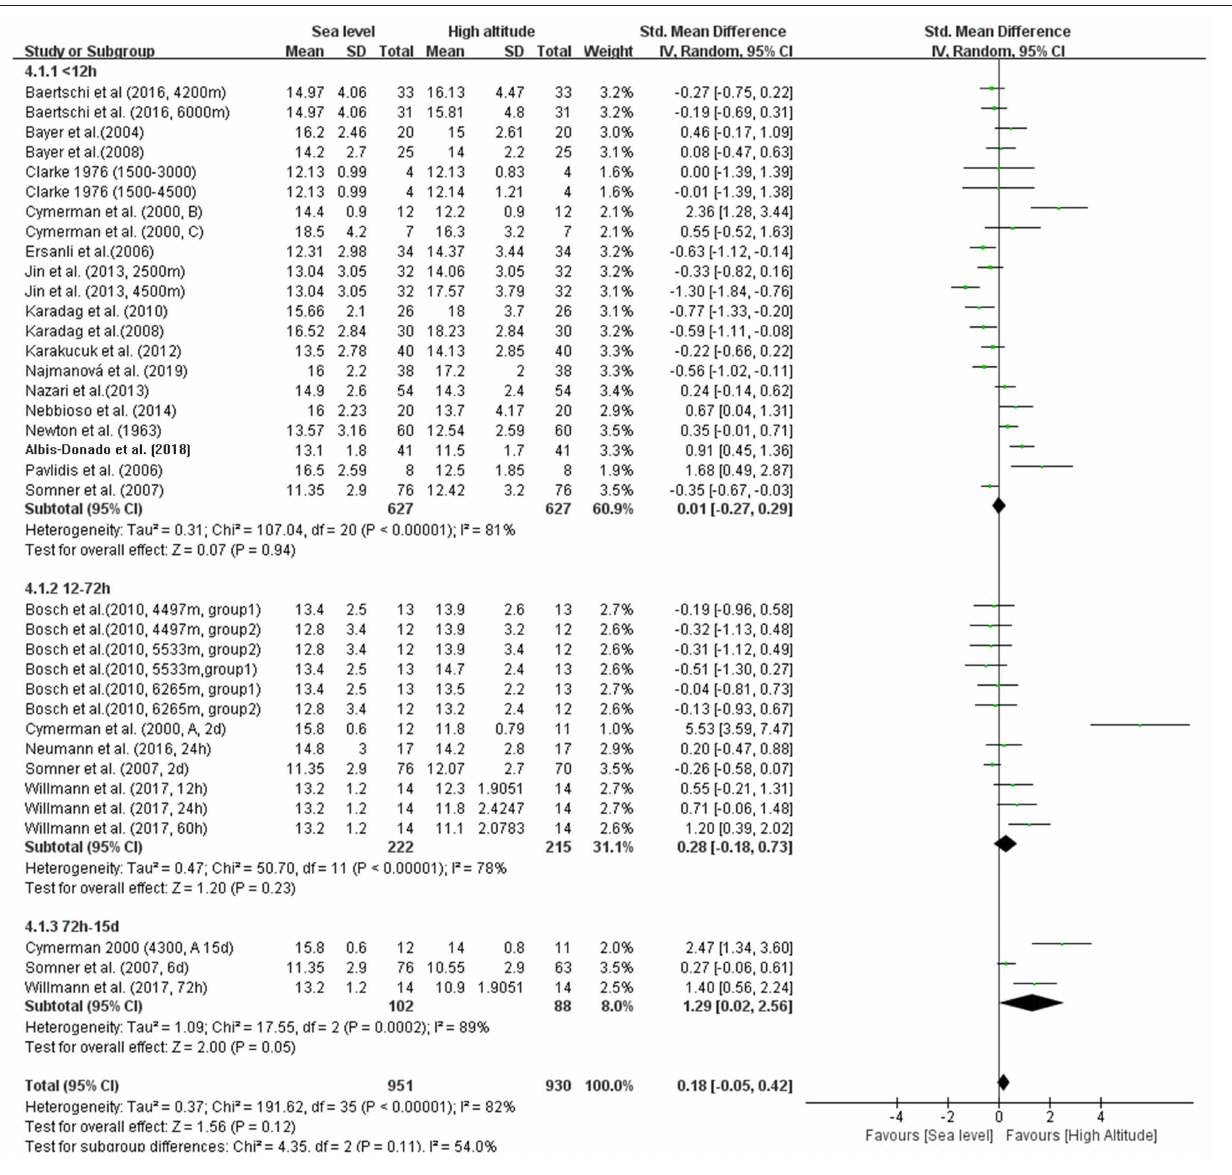
FIGURE 4 | Forest plot of subgroup analysis for duration of high altitude